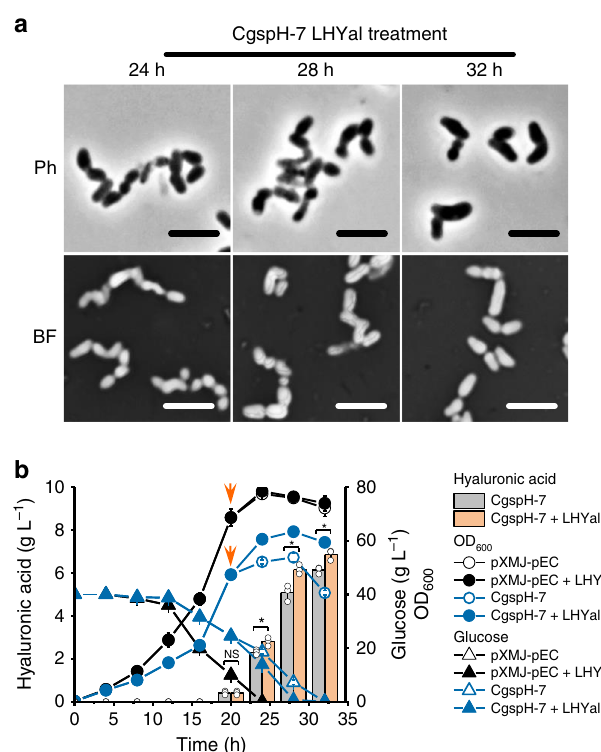
Fig. 5 Disruption of HA encapsulation promotes C. glutamicum cell growth and HA synthesis. a Representative micrographs of CgspH-7 supplemented with 6000 U mL − 1 LHYal after 20 hours of shake- fl ask cultivation (refer to b for the cultivation details). Cell encapsulation was disrupted by LHYal. Ph, phase-contrast microscopy; BF bright- fi eld microscopy. Scale bar, 2.5 μ m. Microcopy experiments were performed three times independently with similar results. b LHYal stimulated cell growth, glucose metabolism, and HA production by the CgspH-7 strain. Time point of LHYal supplementation was indicated with arrows. All the data are expressed as the mean ± S.D. from three ( n = 3) biologically independent replicates. Statistical evaluation ( p- value) was performed by two-sided t -test. * p < 0.05, ** p < 0.01, *** p < 0.001; NS, not signi fi cant ( p ≥ 0.05). Source data underlying Fig. 5a, b are provided as a Source data fi le.